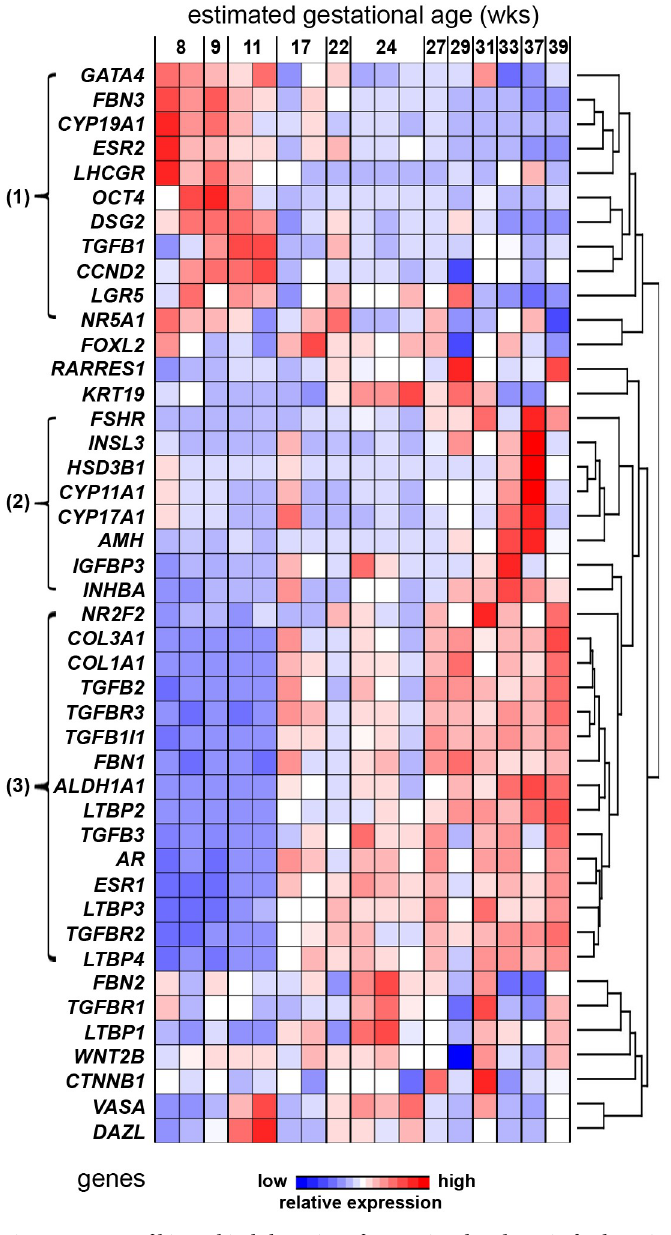
Fig 4. Heatmap of hierarchical clustering of transcript abundance in fetal ovaries throughout gestation. Hierarchical clustering analysis by transcript abundance only (rows) using q-PCR data of 44 genes (gene symbols on left) in n = 16–17 fetal ovaries (one per animal), from 8–39 weeks of gestation (left to right across the top). The raw data were first normalized by adjusting the mean expression across all samples for each gene to zero and the standard deviation to one. The genes were then clustered using the Euclidian algorithm for dissimilarity with average linkage in Partek Genomics Suite ™ (dendrogram on far right). Three transcript abundance clusters were identified as indicated by numbers and brackets on far